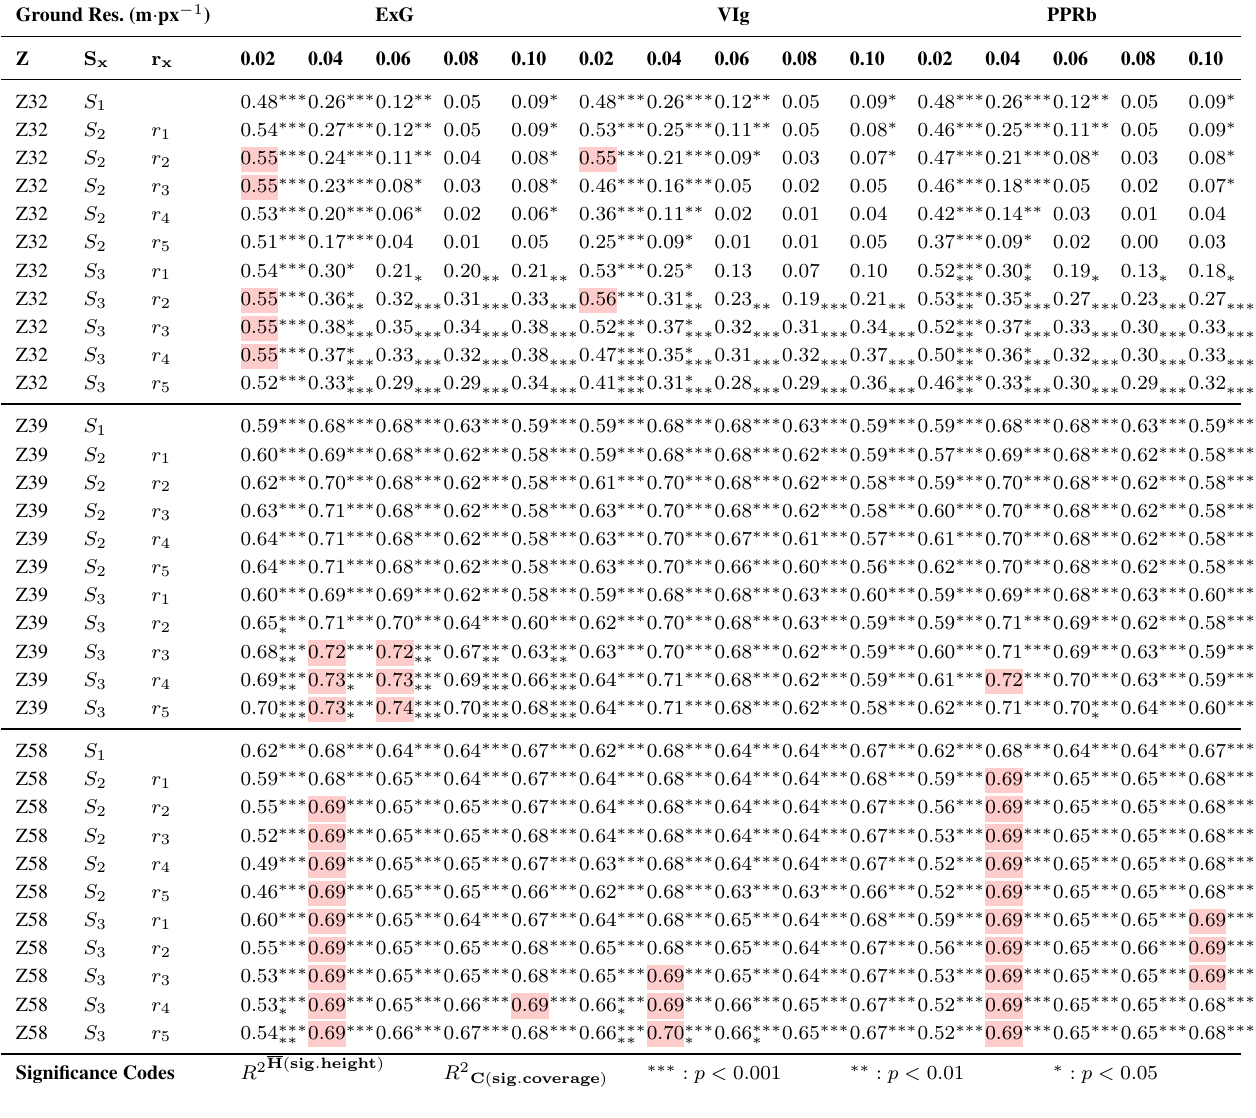
Table 5. The resulting determination coefficients R 2 of the prediction of corn grain yield by applying strategies S for all combinations of VIs, aerial image ground resolutions, crop 1 − 3 growth stages and computed Ridler thresholds. Significance codes for predictor variable crop height are represented as ∗ in superscript, whereas significance codes for predictor variable crop coverage factor are represented as in subscript (appearing only in strategy S ∗ 3